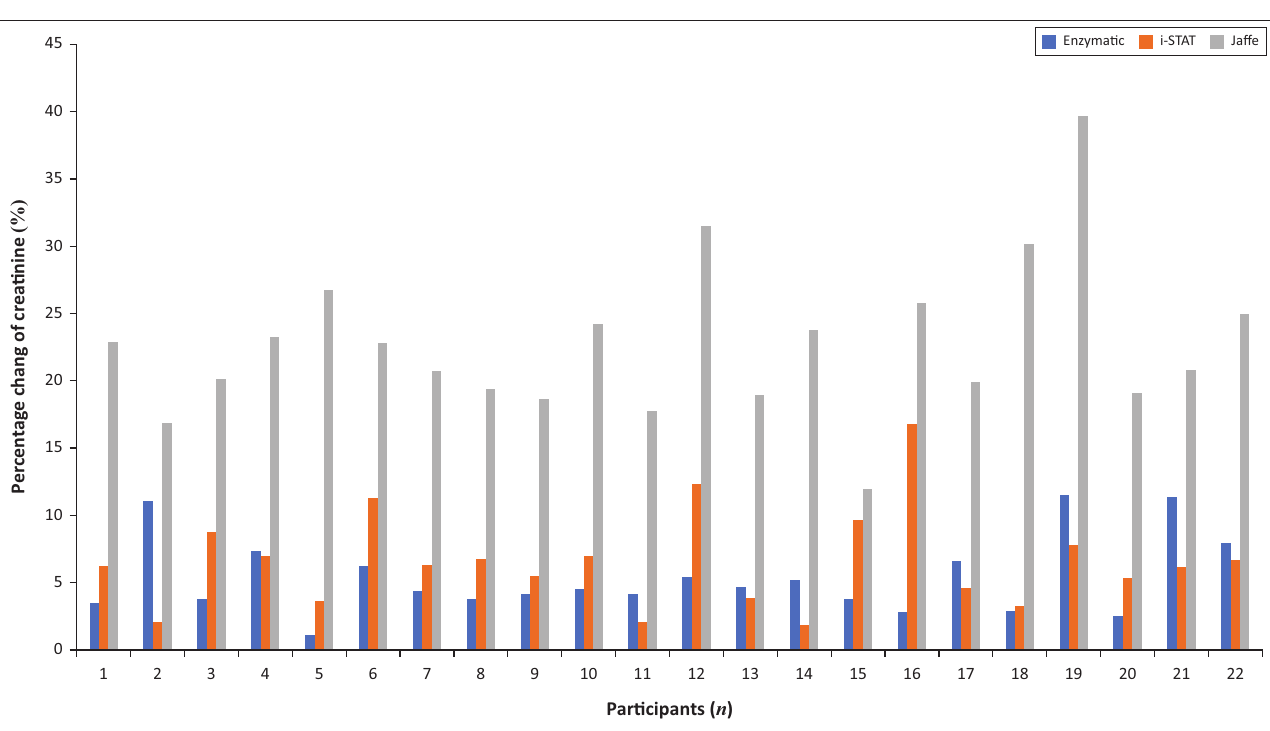
FIGURE 1: Intra-individual coefficient of variation for 22 participants for the enzymatic, kinetic Jaffe and i-STAT creatinine methods over the 96-h study period. Blue bars represent results obtained for the enzymatic method, orange bars for the i-STAT method and grey bars for the kinetic Jaffe method.